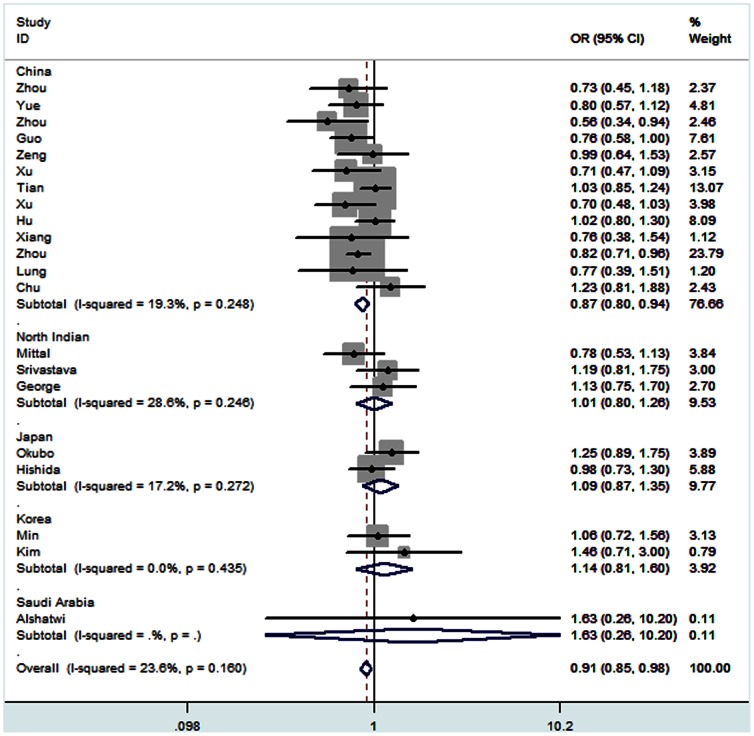
Forest plots of effect estimates for rs2910164 stratified by country (GC vs GG).For each studies, the estimate of OR and its 95% CI is plotted with a box and a horizontal line. Filled diamond pooled OR and its 95% CI.